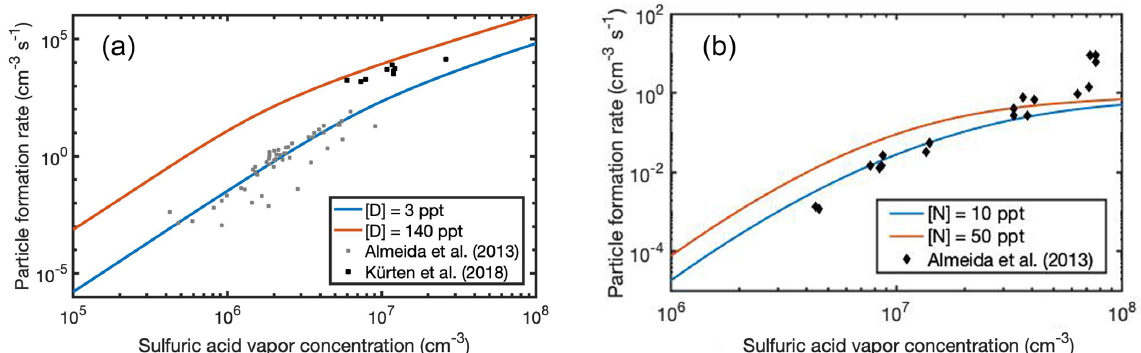
Figure 9. Particle formation rates observed at the CLOUD4 chamber experiment (markers) as a function of sulfuric acid vapor concentration at [D] = 3–140ppt V (a) and [N] = 10–50ppt V (b) , and ACDC simulation results for particle formation in the presence of ions (lines). Note the different scales of x and y axes.